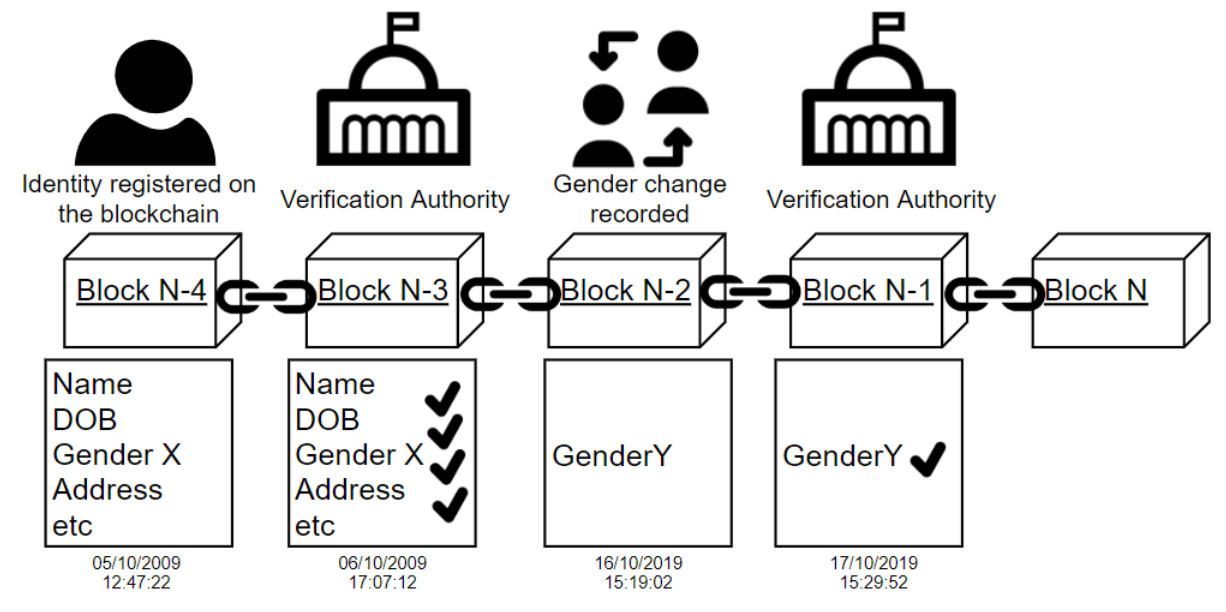
Figure 2: Establishing identity on the blockchain. Subject’s identity attributes are verified by a verification authority and a verification claim to the blockchain. Any changes in the identity attributes yields the old claim to be invalid and new verification is required in order to establish trust. Each claim has a timestamp and possibly a validity